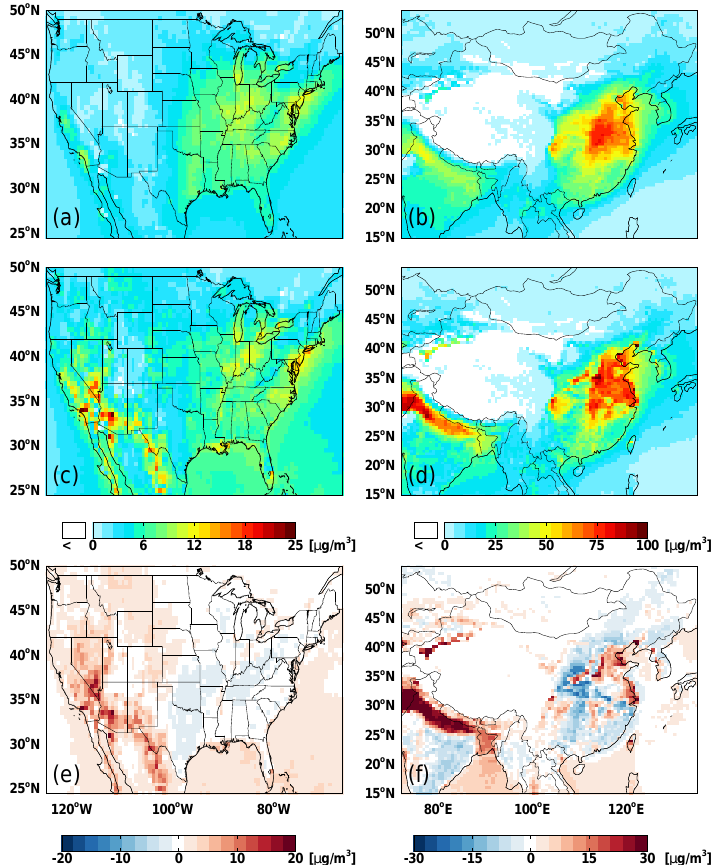
Figure 3. Long-term average (2004–2011) unconstrained model simulation of PM 2 . 5 for the (a) continental US and (b) China, along with the (MODIS-Aqua Collection 6) satellite-based PM 2 . 5 for the (c) continental US and (d) China, and the difference between the satellite- constrained and unconstrained model PM 2 . 5